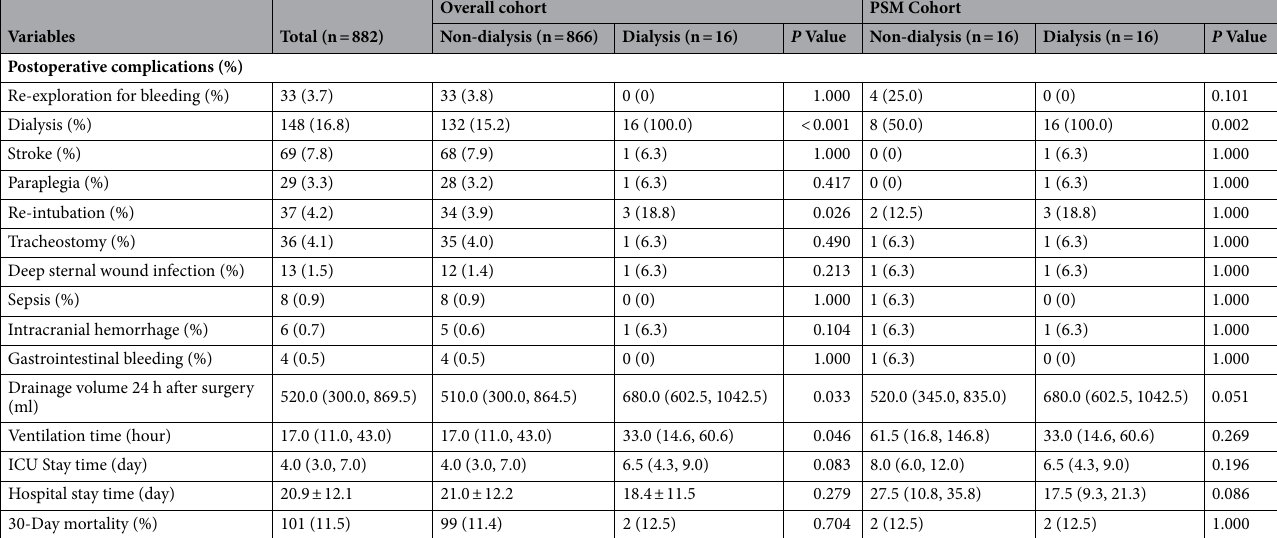
Table 4. Comparison of postoperative variables. Values for categorial variables are given as count (percentage); values for continuous variables are given as median (interquartile range) or mean ± standard deviation. ICU intensive care unit, PSM propensity score matching.